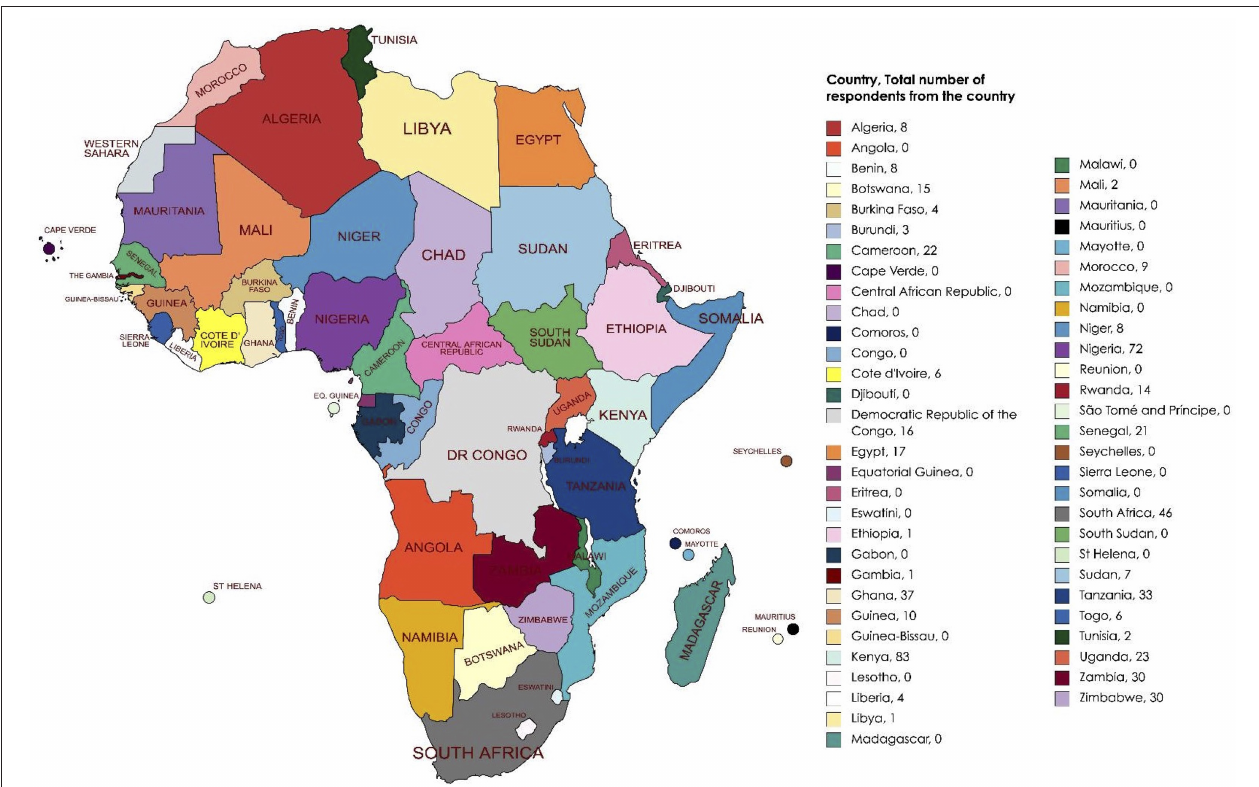
FIGURE 2 | Continental heat map of African countries and number of students that responded to the survey.